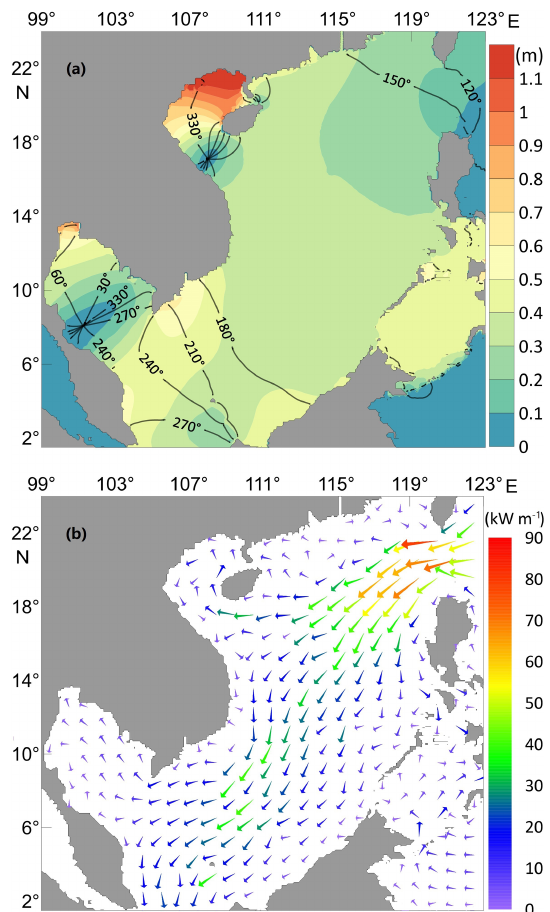
Figure 2. Model-produced K 1 tidal system. (a) The distribution of Greenwich phase lags (in degrees) and amplitudes (color, in me- ters). (b) Tidal energy flux density vectors (in kWm − 1